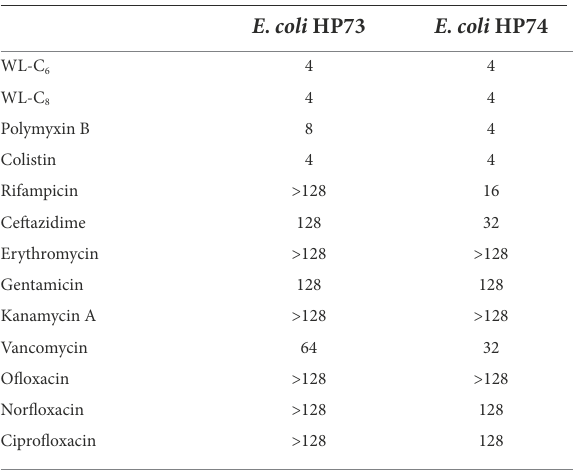
TABLE 2 Antimicrobial activity of the peptides against multidrug- resistant